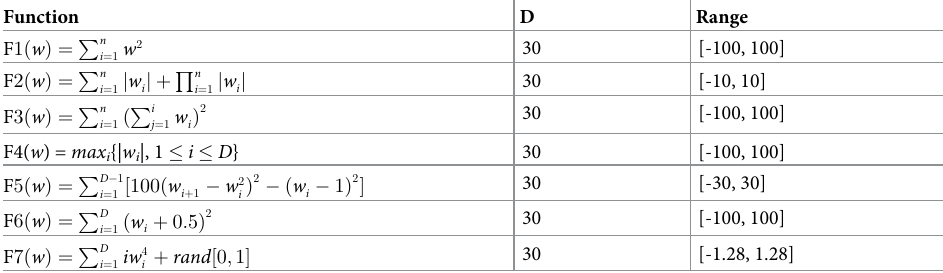
Table 11. Unimodal benchmark functions (F1 to